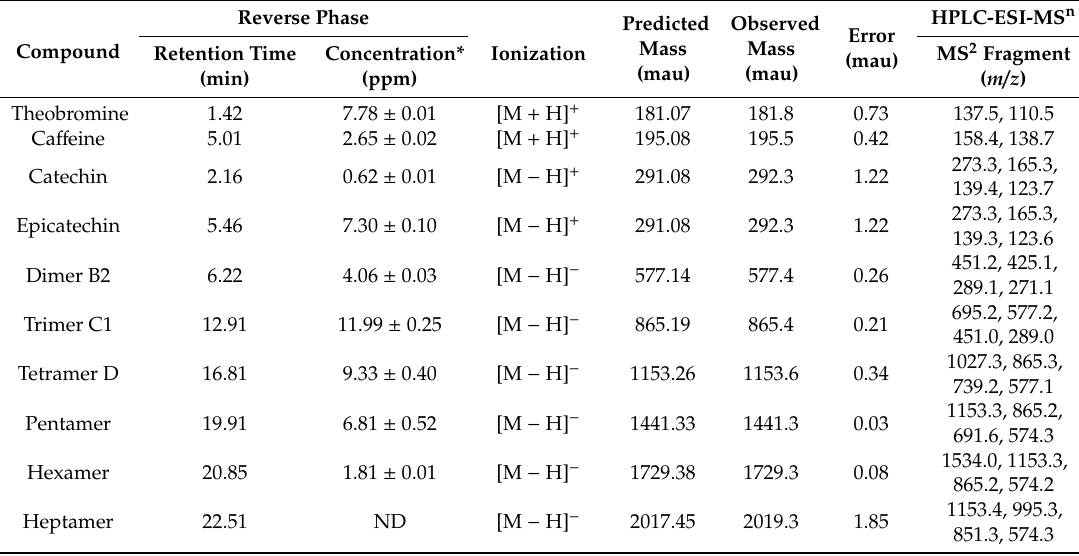
Table 4. Methylxanthine and procyanidin concentration, and characterization of cocoa beans using a HPLC-DAD-ESI-MS / MS method.